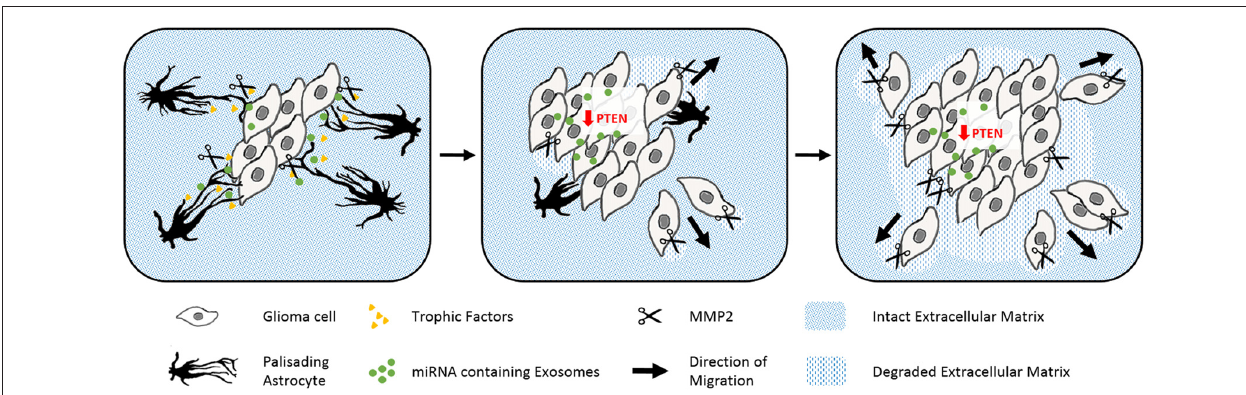
FIGURE 4 | The abuse of scarring astrocytes by glioma. Schematic drawings of how reactive astrocytes turn from initially tumor containing to cancer promoting cells. Astrocytes (black) form prominent palisading processes in response to growing glioma masses (gray rhomboid cells). Glioma derived signals force the reactive astrocytes to secret trophic factors (yellow), pro matrix metalloproteinase-2 (scissors) and microRNA containing exosomes (green, left). The uptake of microRNA containing exosomes evokes the epigenetical downregulation of tumor suppressing PTEN in glioma. PTEN depletion and astrocyte-derived trophic signals enhance the cell proliferation of the glioma cells. Expanding tumor cells use matrix metalloproteinases to degrade the surrounding extracellular matrix (blue stripped pattern) and begin to penetrate the glial scar (center). In the late phase, glioma have comprehensively degraded their adjacent extracellular matrix and seemingly consumed the originally tumor encompassing astrocytes